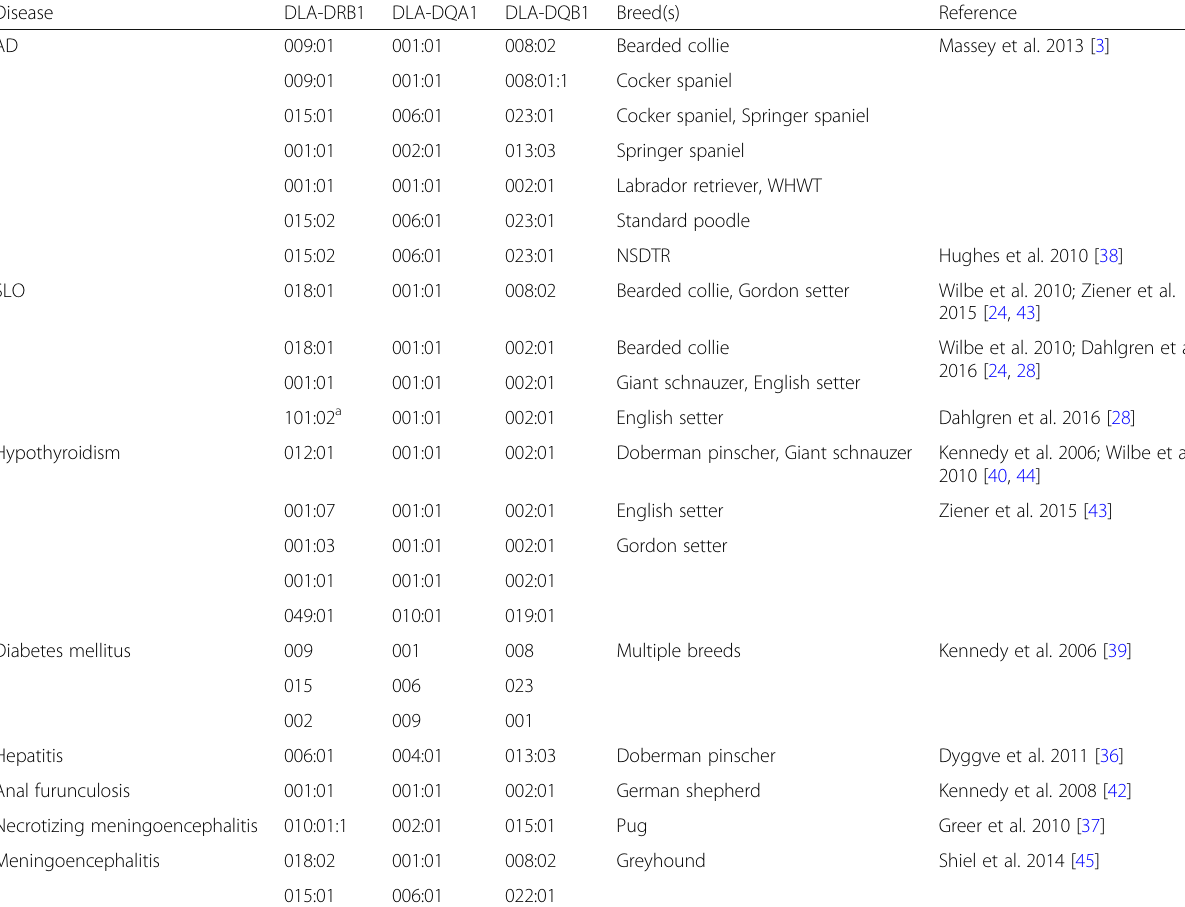
Table 1 Published three-locus DLA class II haplotypes associated with increased risk for some immune-related diseases in dogs